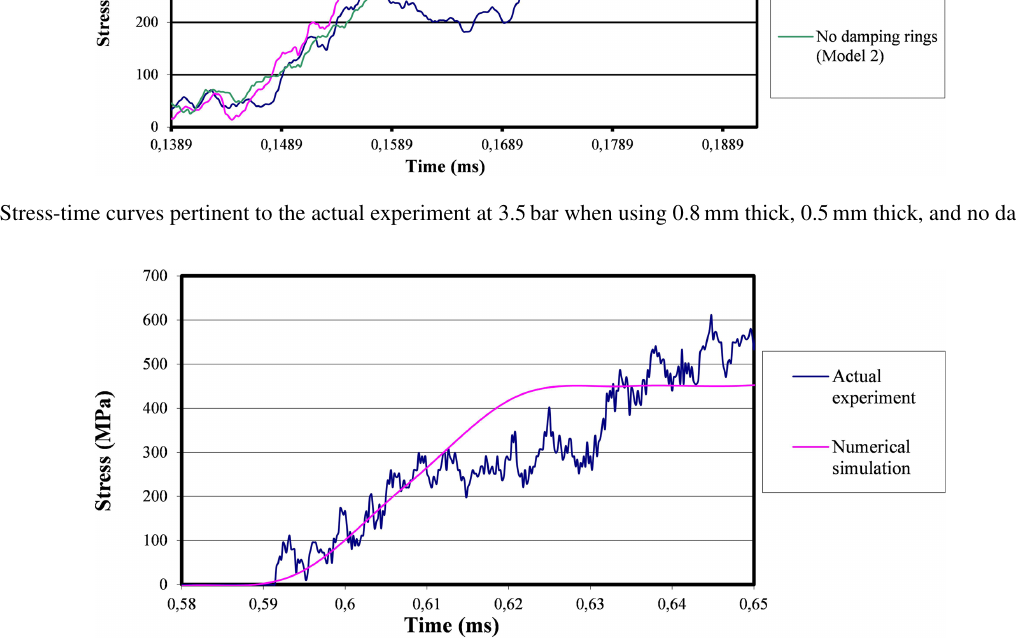
Figure 36. Comparison between the stress-time curves obtained by accomplishing both the actual experiment in the laboratory and the numerical simulation when using 1mm-thick damping